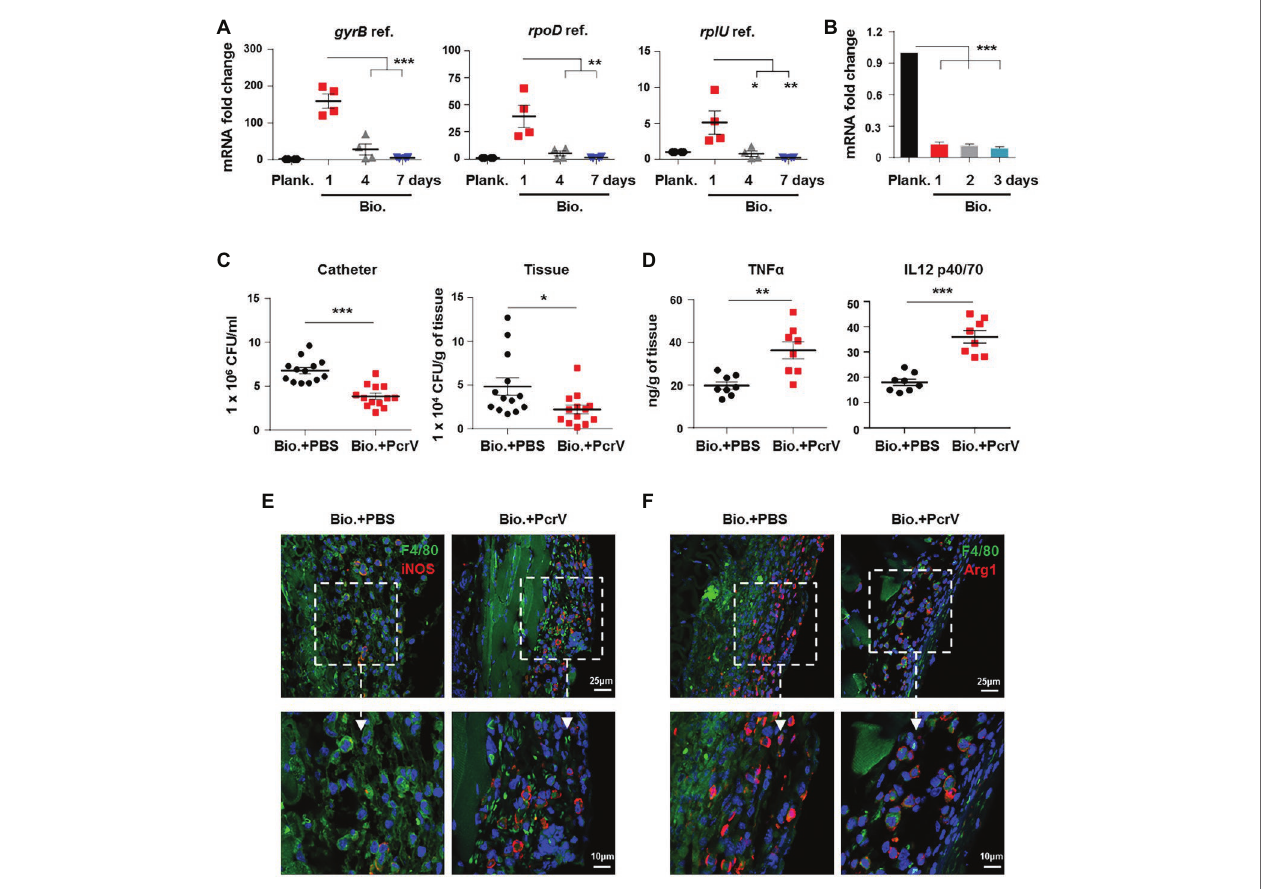
FIGURE 2 | Decreased expression of P. aeruginosa PcrV gene following biofilm infection promotes biofilm persistence. (A) P. aeruginosa -infected catheters were subcutaneously implanted into C57BL/6 mice, and catheters were harvested after infection for 1, 4, and 7 days. The pcrV gene expression in biofilm catheter or planktonic bacteria harvested before infection was analyzed by RT-qPCR. P. aeruginosa gyrB , rpoD , and rplU genes were used as reference genes (abbreviated as ref.). (B) The pcrV gene expression in P. aeruginosa static biofilms or planktonic bacteria was analyzed by RT-qPCR using rplU genes as reference gene. After infection for 4 days, 10 μ g of PcrV was daily injected into the tissues surrounding the biofilm-infected catheters for three times. Infected tissues and catheters were harvested at day 8. Bacterial loads in infected tissues or catheters were determined by counting CFU (C) and production of TNF α and IL12 p40/70 was detected by ELISA assay (D) . F4/80 + /iNOS + and F4/80 + /Arg1 + macrophages in tissues surrounding the biofilm-infected catheters were detected by immunofluorescence staining (E,F) . For immunofluorescence staining, M1 macrophages were counterstained with FITC-conjugated anti-F4/80 and AF647-conjugated anti-iNOS antibodies. M2 macrophages were counterstained with FITC-conjugated anti-F4/80 and AF647-conjugated anti-Arg1 antibodies; cellular nuclei were stained with DAPI. One-way ANOVA (Tukey’s post hoc , A,B ) or an unpaired Student’s t test (C,D) was used for statistical analysis. * p < 0.05; ** p < 0.01; *** p <